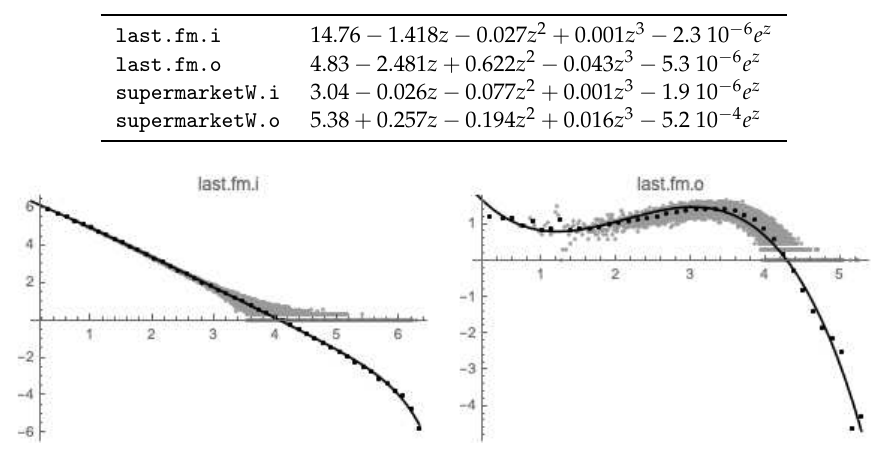
Table 6. Solutions of four selected bipartite graphs.